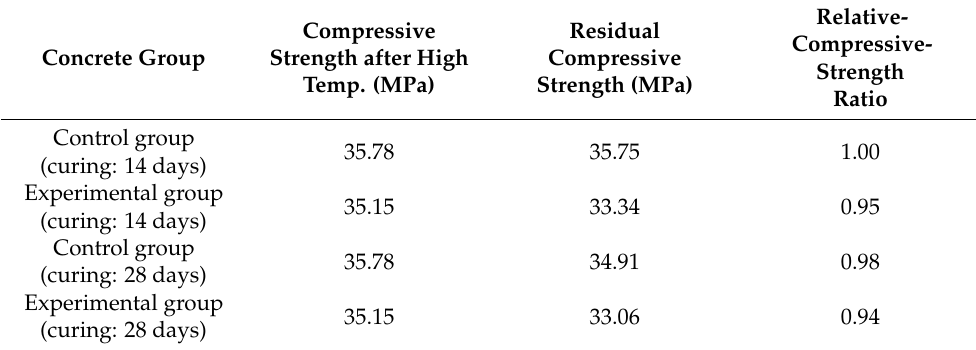
Table 15. Relative-compressive-strength ratios of the self-healing concrete after exposure to high temperature.